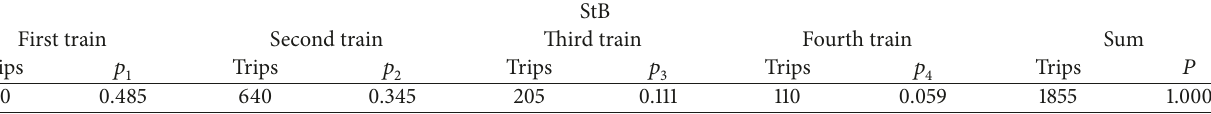
Sum Table 2: The parameter of StB of down direction during 8:00 AM ∼ 9:00 AM at the station of Yanchang Rd. StB First train Second train Third train Fourth train Sum